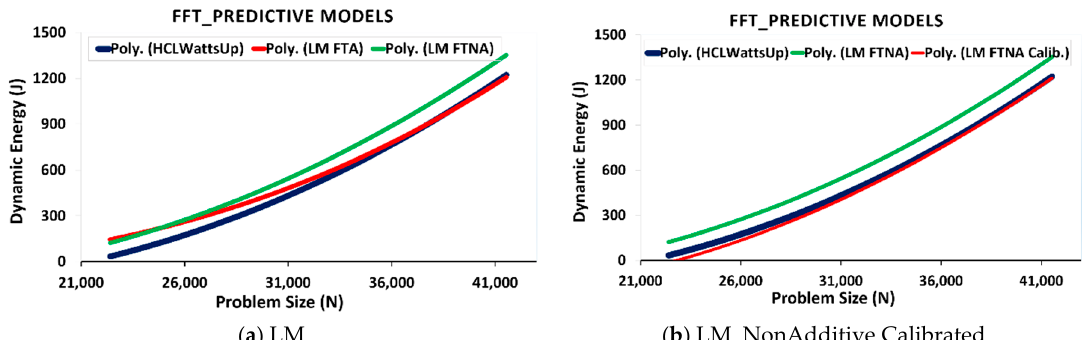
Figure 8. Regression models of energy profiles in EPS FFT_Predictive Models, ( a ) Linear Models, and ( b ) Linear Model NonAdditive Calibrated. Here, LM refers to Linear Model.